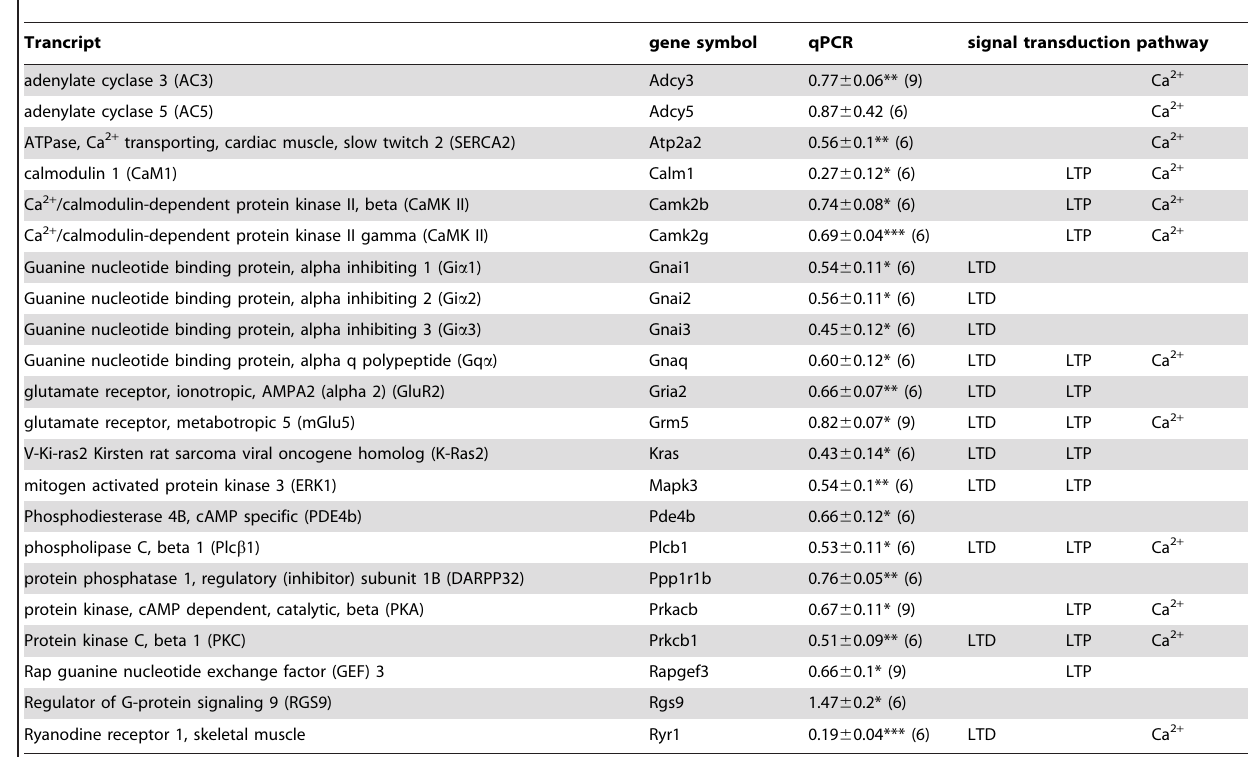
Table 1. Expression analysis using qPCR of selected transcripts involved in LTD, LTP and Ca 2 +